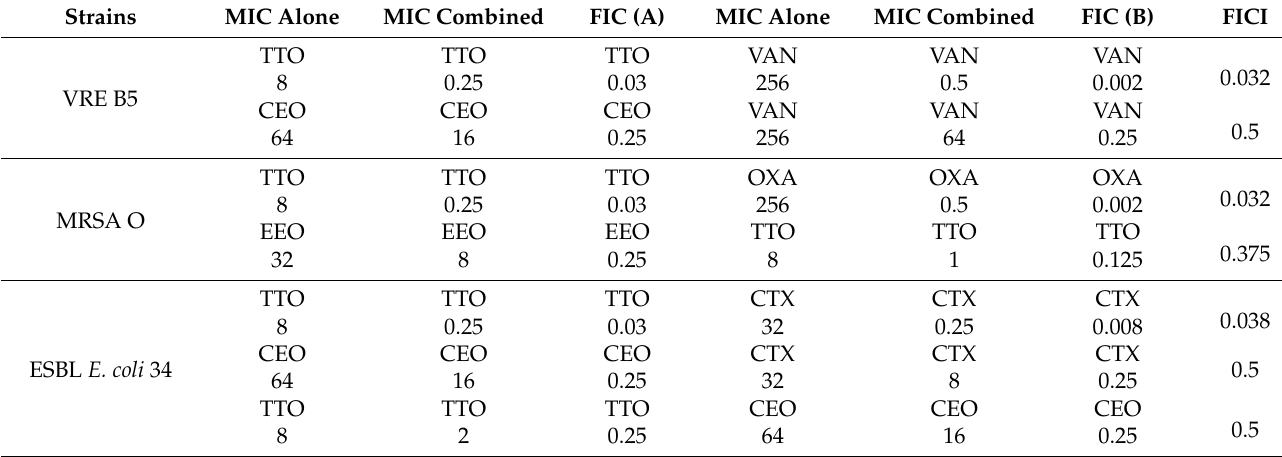
Table 6. Examples of synergy between MIC ( µ g/mL) of antimicrobials alone and of EO–EO association and EO–antibiotic combination against antibiotic-resistant pathogens (one for each genus).